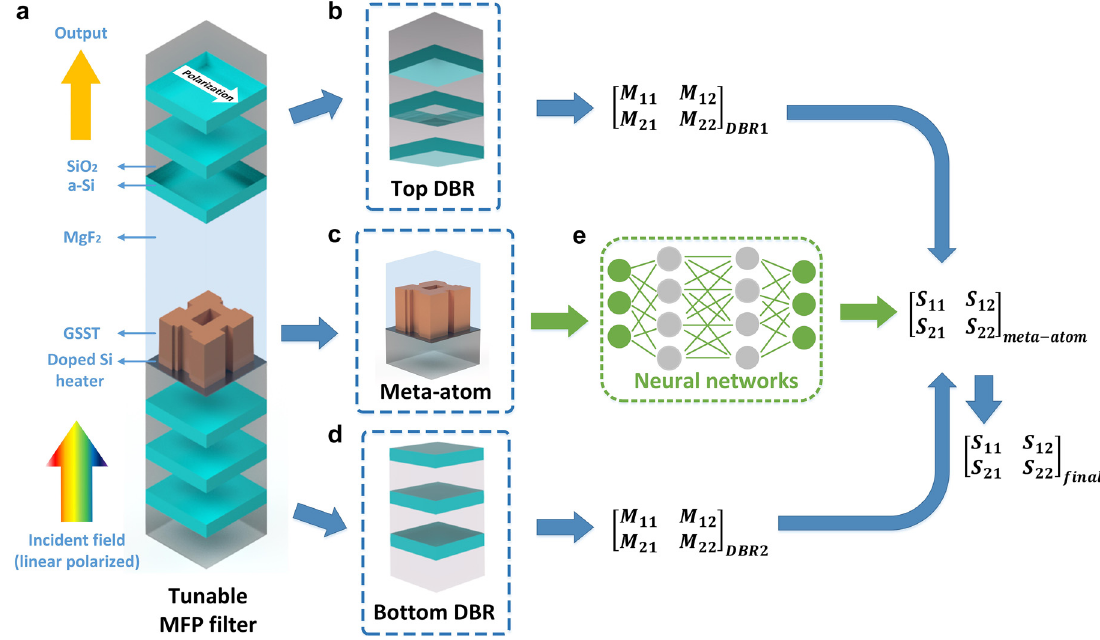
Figure 1: MFP filter design